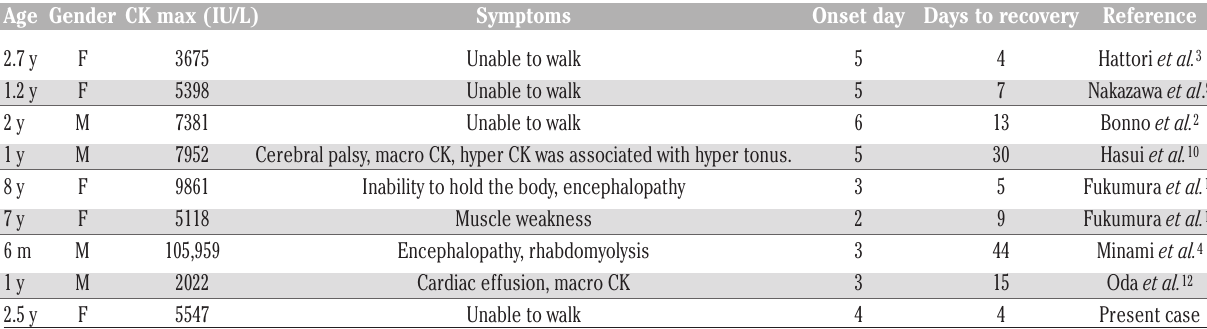
Table 1. Cases manifesting creatine phosphokinase (CK) elevation during the course of rotavirus infection. Age Gender CK max (IU/L)